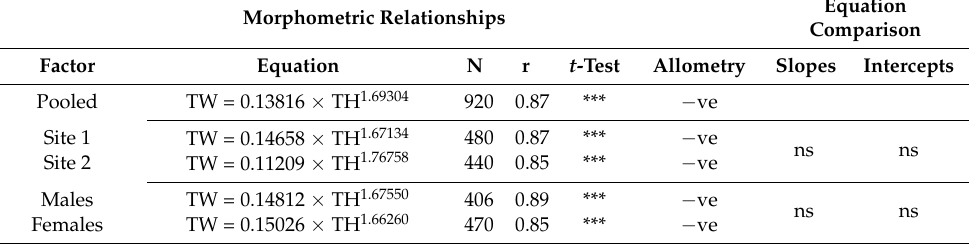
Table 3. Allometric equations between test diameter (TD), test height (TH), total weight (ToW)